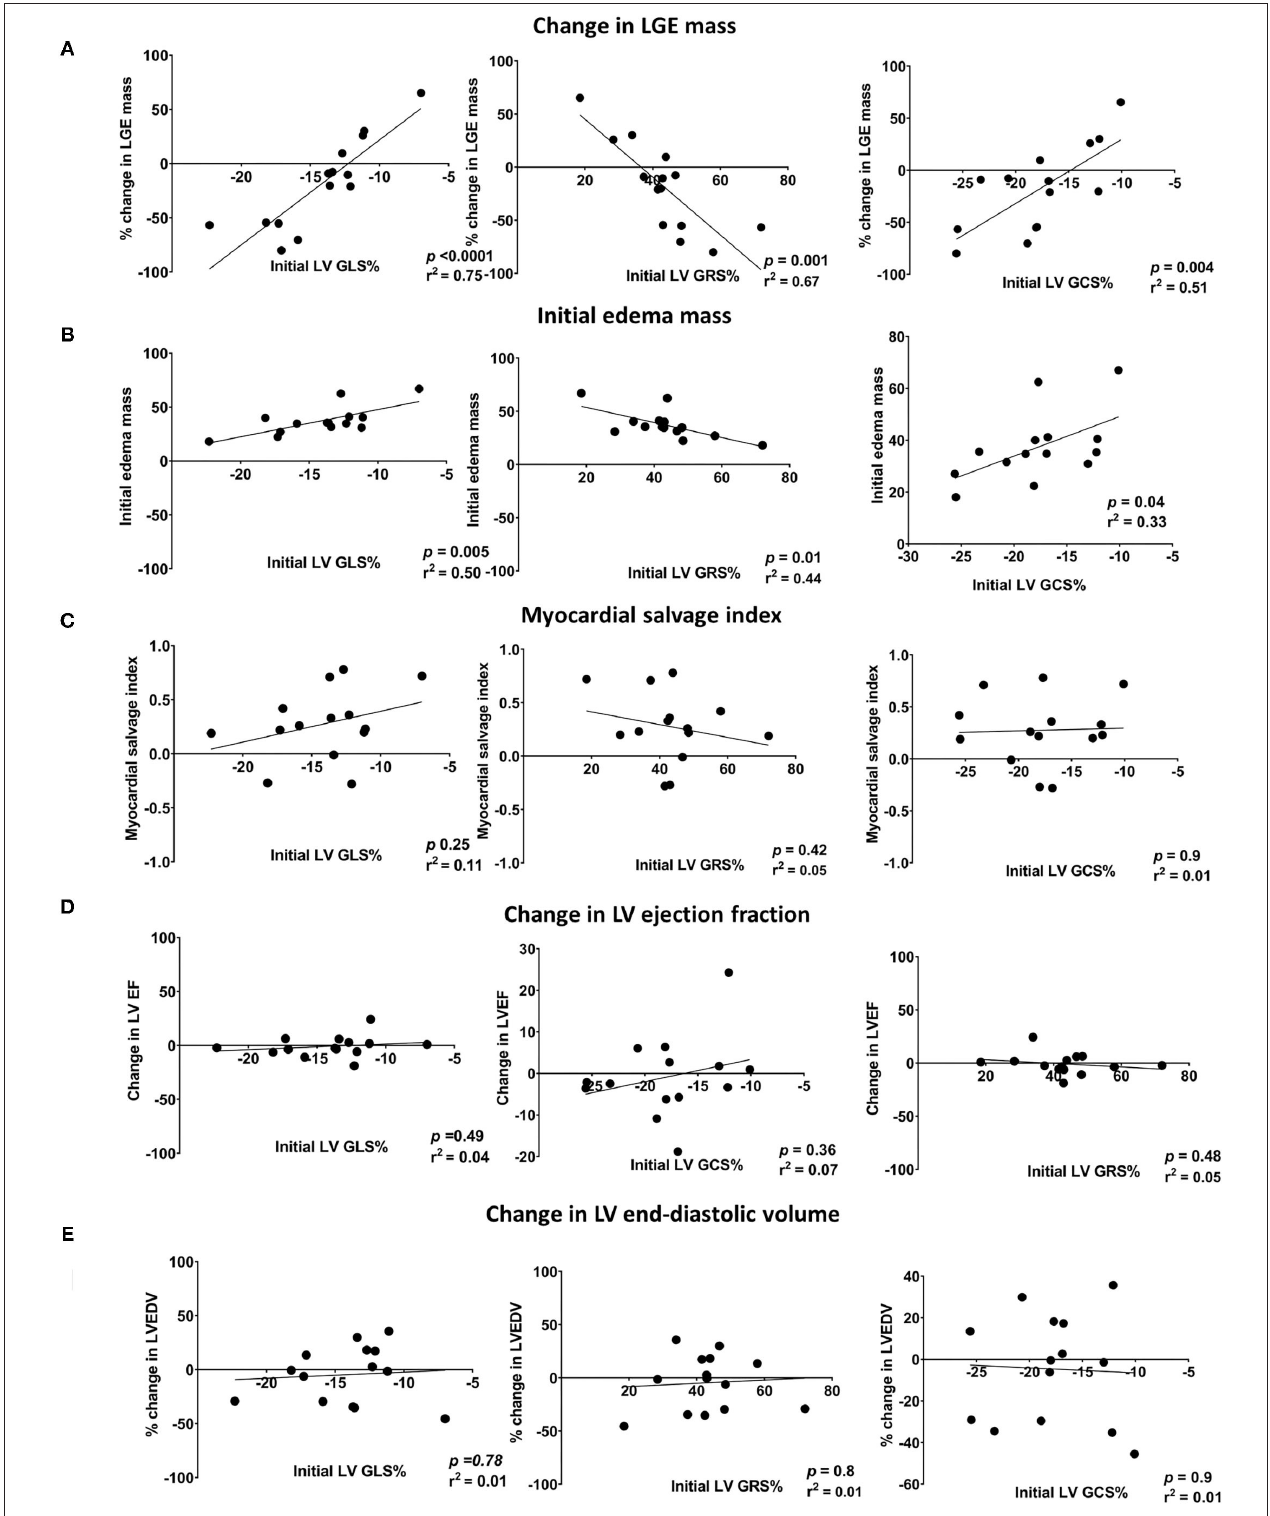
FIGURE 3 | Scatter plots showing the linear correlations between initial LV global strains (GLS, GRS, and GCS) and changes in (A) LGE mass, (B) edema mass, (C) LVEF, (D) CO, and (E) LVEDV. LV EF, left ventricular ejection fraction; LV GCS, left ventricular global circumferential strain; LV GLS, left ventricular global longitudinal strain; LV GRS, left ventricular global radial strain; LV EDV, left ventricular end-diastolic volume; LGE, late gadolinium enhancement; CO, cardiac output.